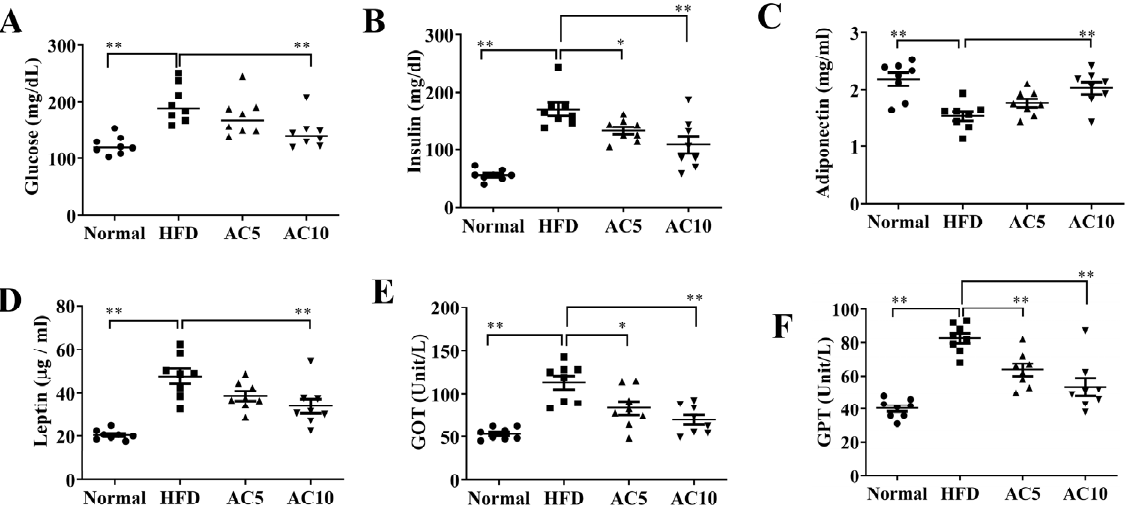
Figure 7. Serum biochemical analysis in mice. Levels of ( A ) glucose, ( B ) insulin, ( C ) adiponectin, ( D ) leptin, ( E ) GOT, and ( F ) GPT. Values are presented as mean ± SEM. * p < 0.05, ** p < 0.01 indicate significant differences compared to obese mice.